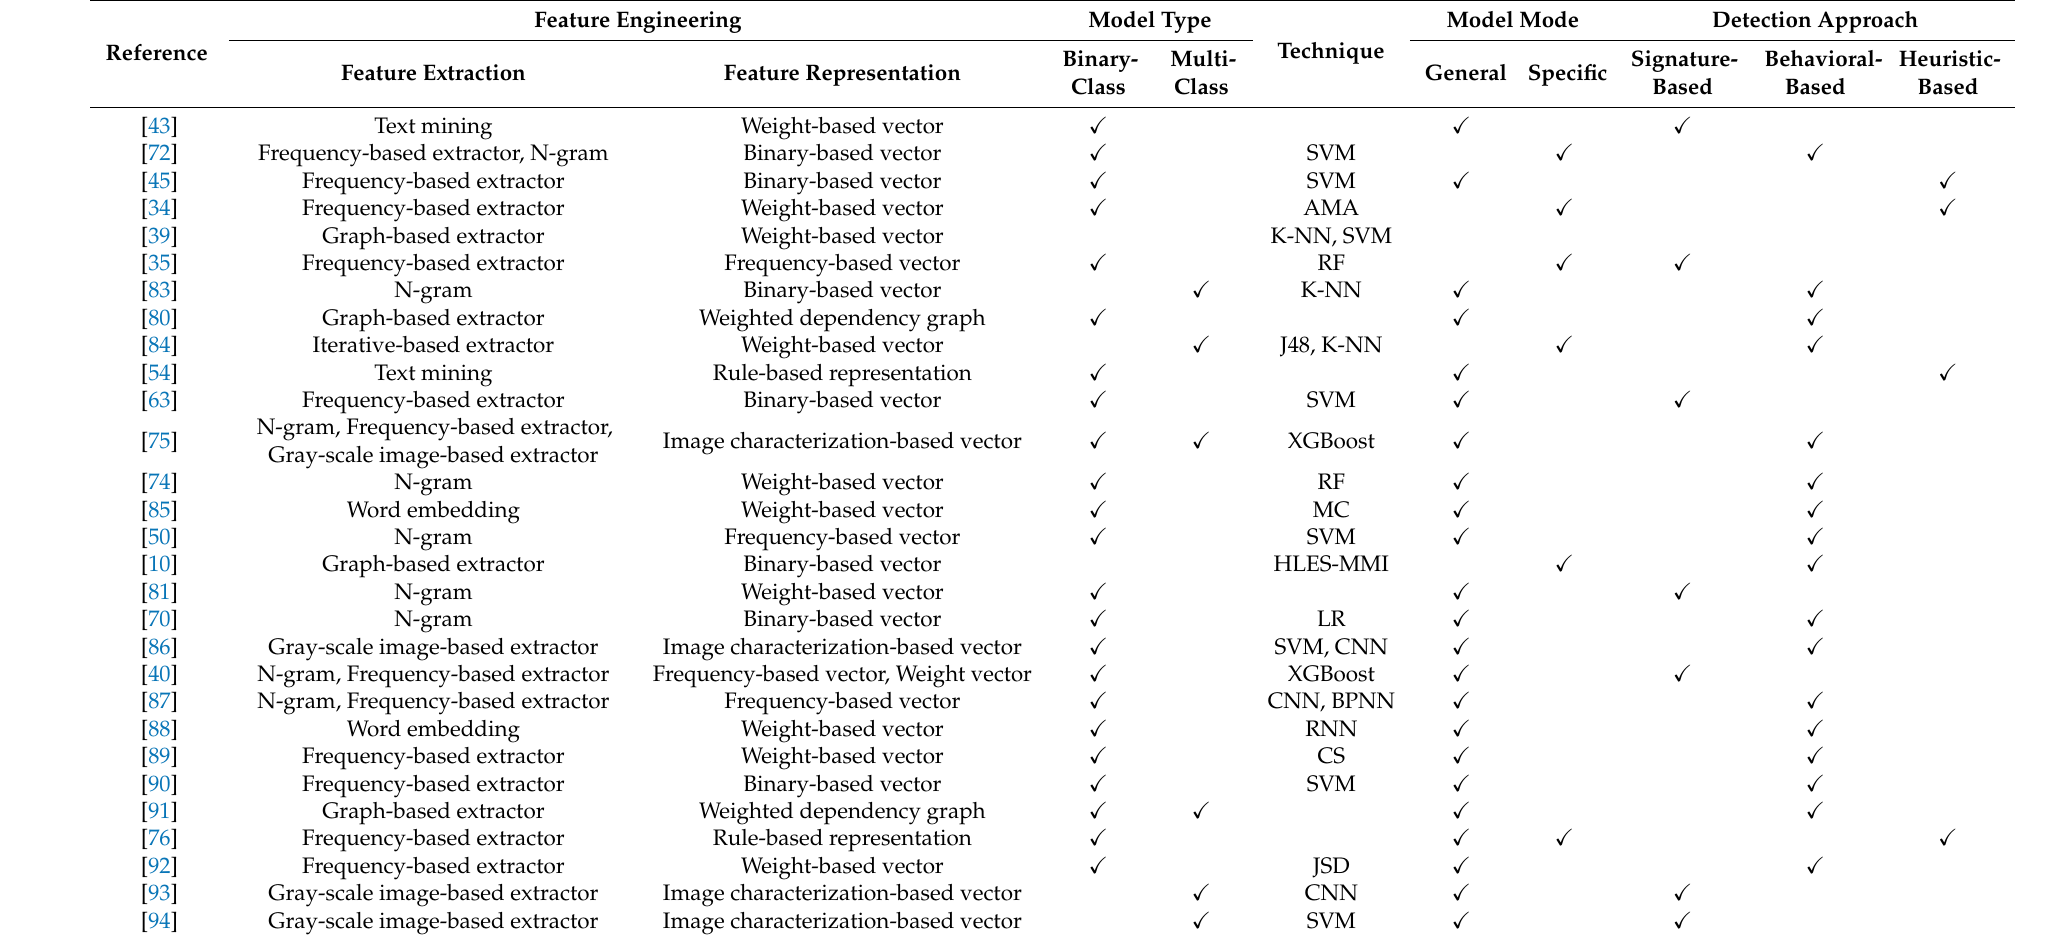
Table 3. Summary of detection approaches, extraction, and representation